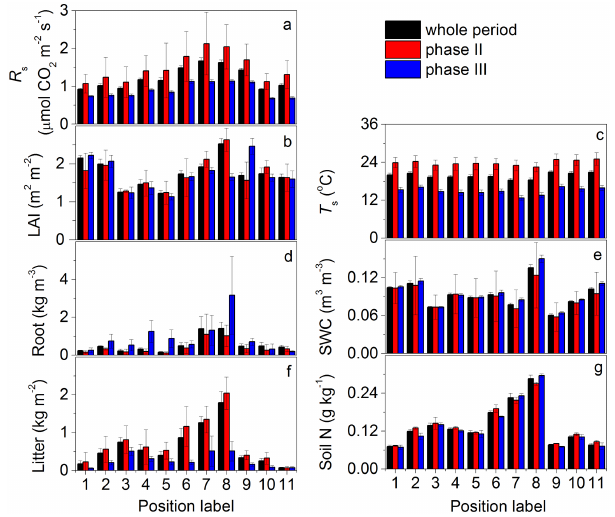
Figure 3. Mean values of soil respiration ( R s ), microhydrometeo- rological ( T s and SWC) and plant-related factors (litter, root, soil N and LAI) at 11 positions over the measurement period (whole period), flower-bearing phase (phase II), and leaf coloration– defoliation phase (phase III) from June to October 2012. Timescales of each phenophases are shown in Fig. 2. R s : soil respiration (µmol CO 2 m − 2 s − 1 ); T s : soil temperature ( ◦ C); SWC: volumetric soil water content (m 3 m − 3 ); Litter: litterfall (kgm − 2 ); Root: root biomass (kgm − 3 ); LAI: leaf area index (m 2 m − 2 ); Soil N: soil ni- trogen content at 0–25cm soil depths (gkg − 1 ). Error bars represent standard